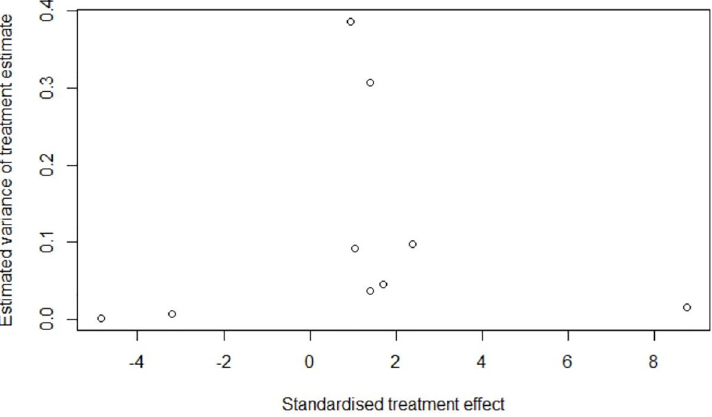
Fig 5. Publication bias assessment: Funnel plot for per-protocol meta-analysis of tuberculosis and risk of cardiovascular disease and related mortality.